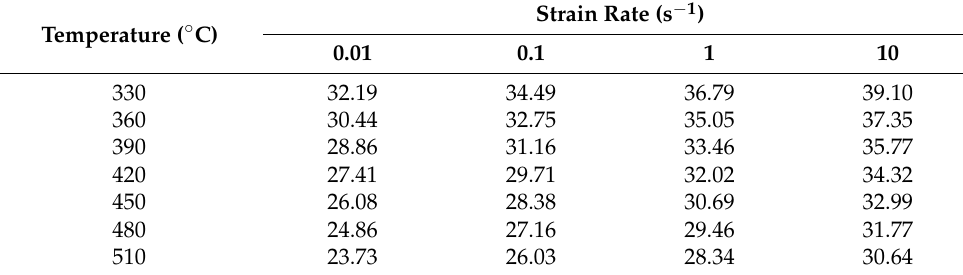
Figure 5. The linear relationships of ln ε versus ln [ sinh ( ασ )] and ln [ sinh ( ασ )] versus 1000/T. ( a ) ln 𝜀 –ln [ sinh ( ασ )] , ( b ) ln [ sinh ( ασ )] –1000/T. Table 3. ln Z values of the 2198 alloy with di ff erent strain rates and temperatures.